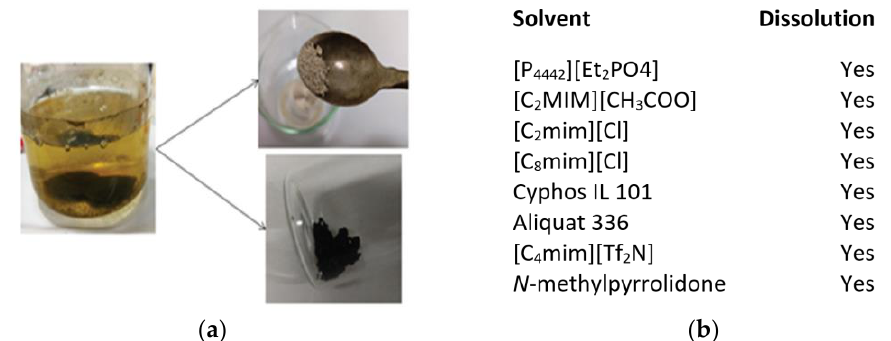
Figure 6. ( a ) Left: Dissolution of polyamide 12 (PA12) in [P 4442 ][Et 2 PO 4 ]; the very fine magnet powder is collected at the bottom with the help of a magnet. Upper right: Isolation of PA12 powder after precipitation by addition of water. Lower right: Isolation of magnet powder that is still coated by a polysiloxane-polyether layer. ( b ) Dissolution experiments on polyamide 12 (PA12) in different solvents. Reproduced from [100] with permission from the Royal Society of Chemistry.